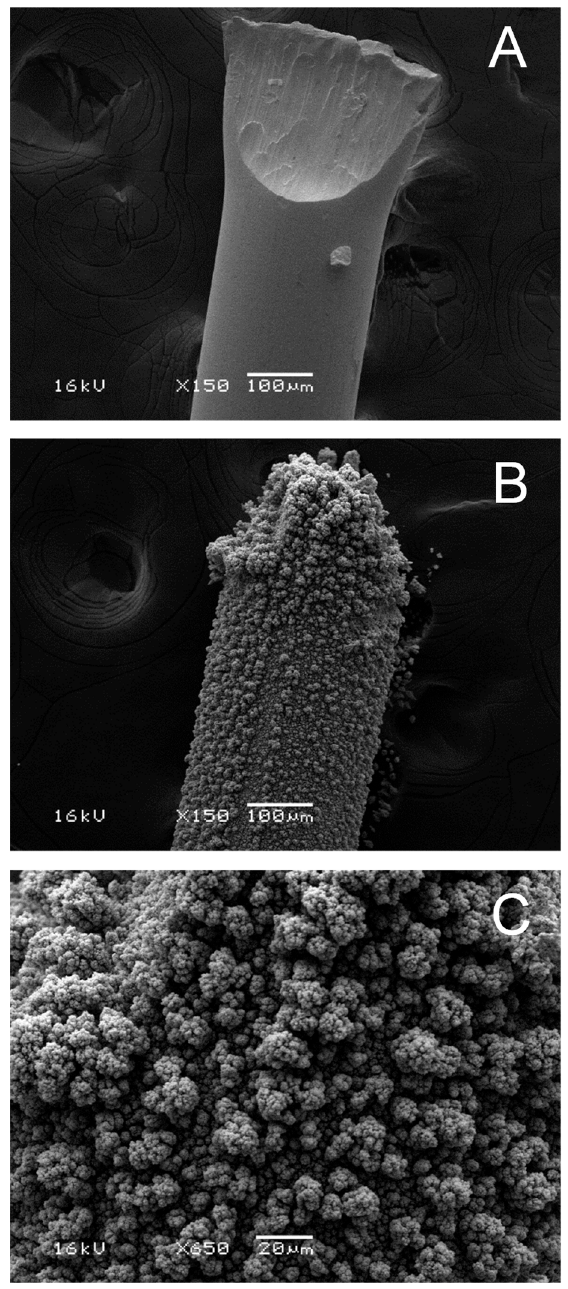
Figure 6. SEM images of Pt-Ir wire (exposed, cut tip) both ( A ) before and ( B ) after modification of Pt black including ( C ) magnified image showing morphology of Pt black. Note: Size bars in each image represent 100 µm, 100 µm, and 20 µm respectively.